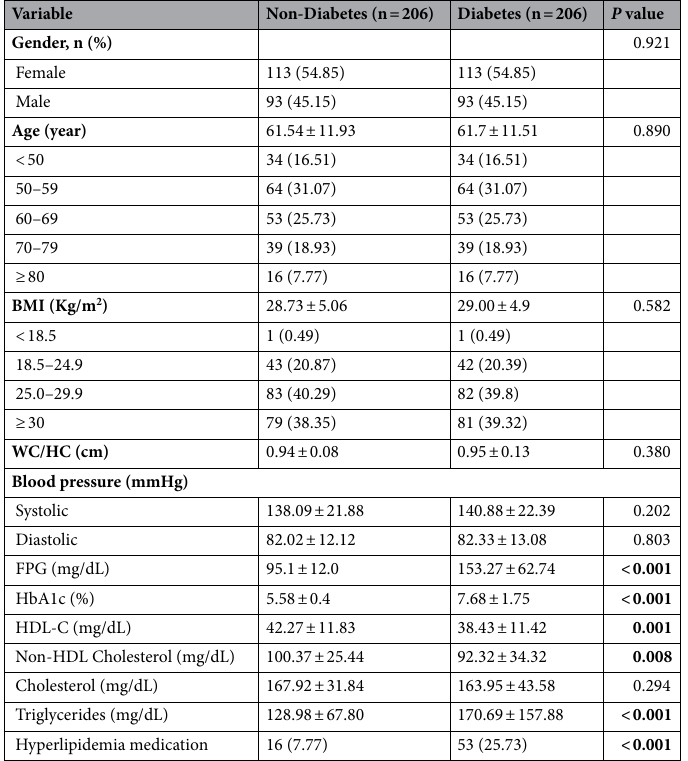
Table 1. Baseline characteristics of study participants. Continuous variables were presented as mean ± SD, and categorical variables were presented as numbers (column percentage). BMI: body mass index, WC/ HC: